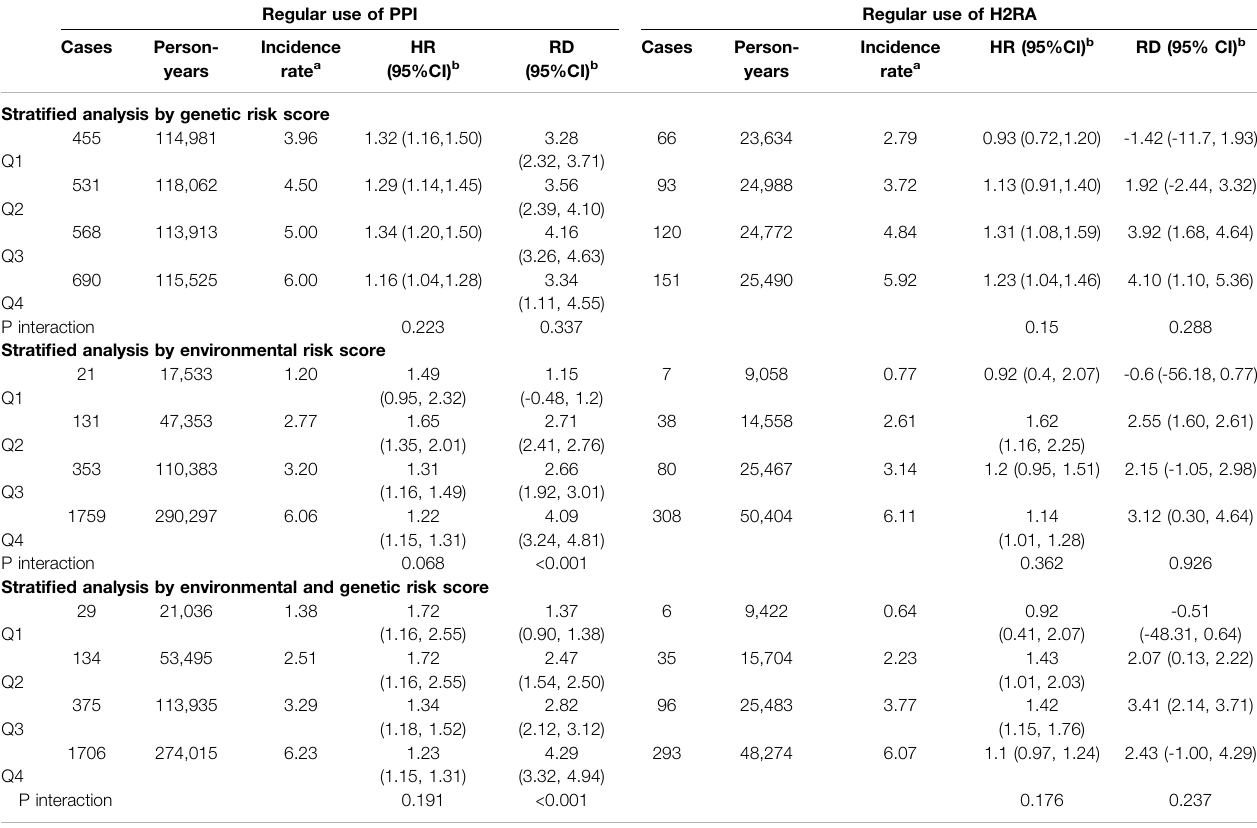
TABLE 4 | Risk strati fi cation by predicted genetic or environmental risk score for cholelithiasis at baseline. Regular use of PPI Regular use of